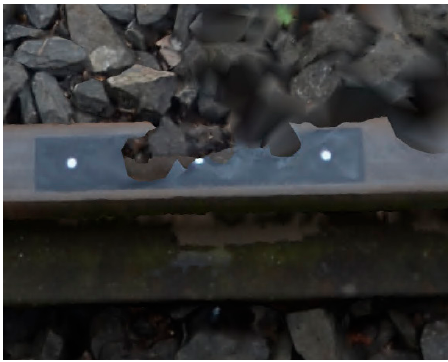
Figure 7. Holes on control points (CrlP) triplet in the 3D mesh model generated by RealityCapture software.